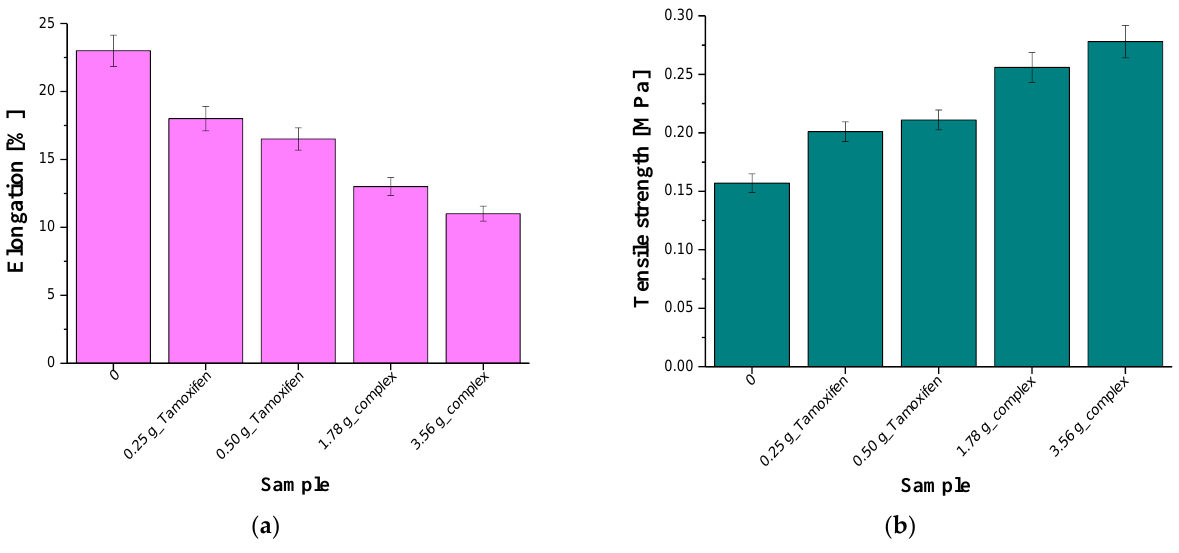
Figure 11. Results of the mechanical studies of the composites showing their elongation ( a ) and the tensile strength ( b ) (n — number of repetitions, n = 3).